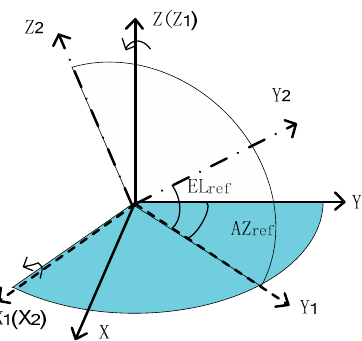
Figure 1. The definition of celestial angles .